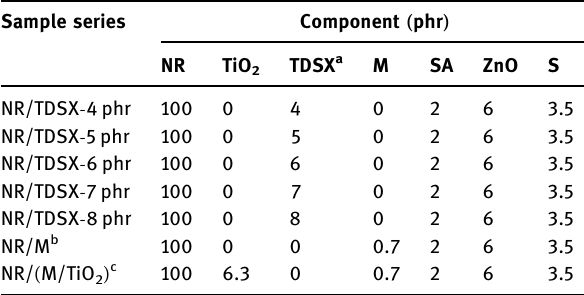
Table 1: Formulas of NR/TDSX, NR/M and NR/ ( M/TiO 2 ) Sample